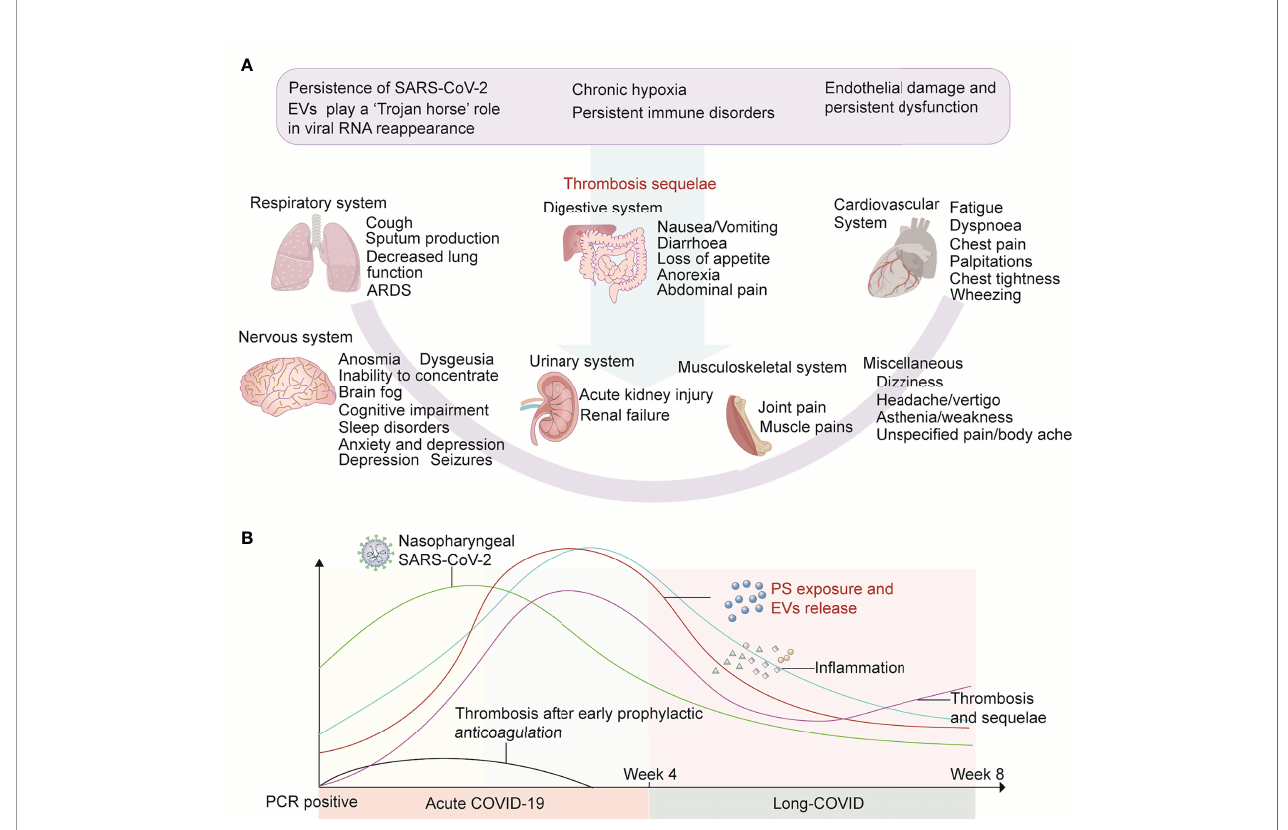
FIGURE 3 | Thrombotic sequelae and possible outcomes of early anticoagulation in long COVID. (A) In long COVID, EV-delivered virus persistently attacks systemic systems, coupled with chronic hypoxia and persistent in fl ammatory responses, which collectively damage the vascular endothelium. The above factors also lead to PS exposure on the surface of various types of cells and EVs from which they are derived. These factors in fl uence each other and together promote thrombosis. (B) We propose a hypothesis that early prophylactic anticoagulation in COVID-19 can quickly remove a variety of procoagulant substances, thereby protecting the blood system and surrounding tissues and organs from damage, inhibiting PS exposure to initiate coagulation, and avoiding thrombosis and